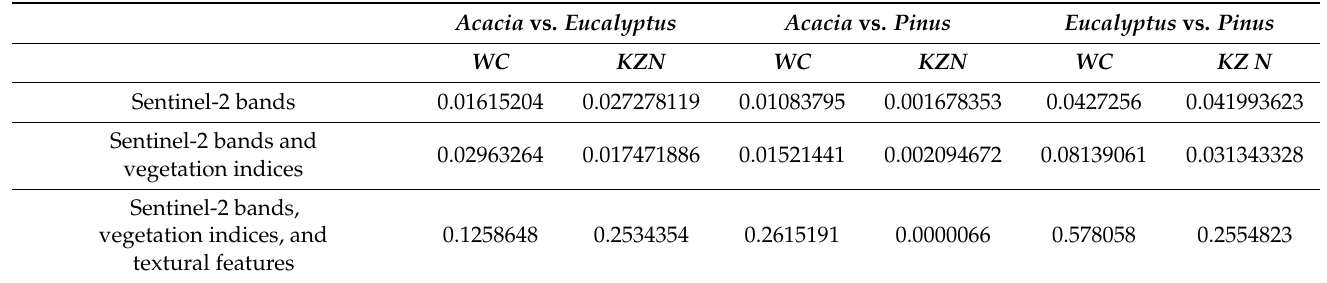
Table 4. Jefferies–Matusita difference scores between Acacia and Eucalyptus , Acacia and Pinus , and Eucalyptus and Pinus using Sentinel-2 bands; Sentinel-2 bands and vegetation indices; and Sentinel-2 bands, vegetation indices, and textural features for both study areas. Acacia vs. Eucalyptus Acacia vs. Pinus Eucalyptus vs. Pinus WC KZN WC KZN WC KZ